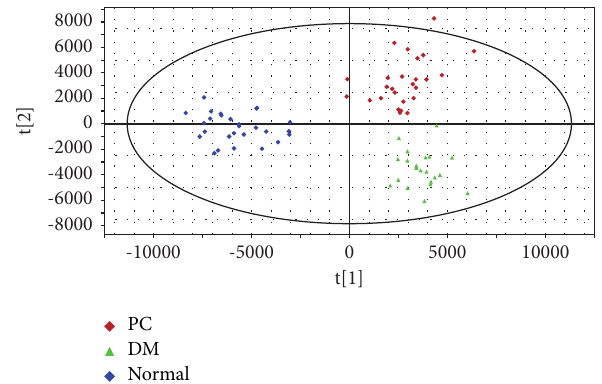
Figure 3: OPLS-DA scores of plasma metabolic profiles in PC, DM, and normal groups, demonstrating the good fitness and predictive ability of the model in identifying the differential metabolite ions. t [1]: the first predicted principal component; t [2]: the first or- thogonal principal